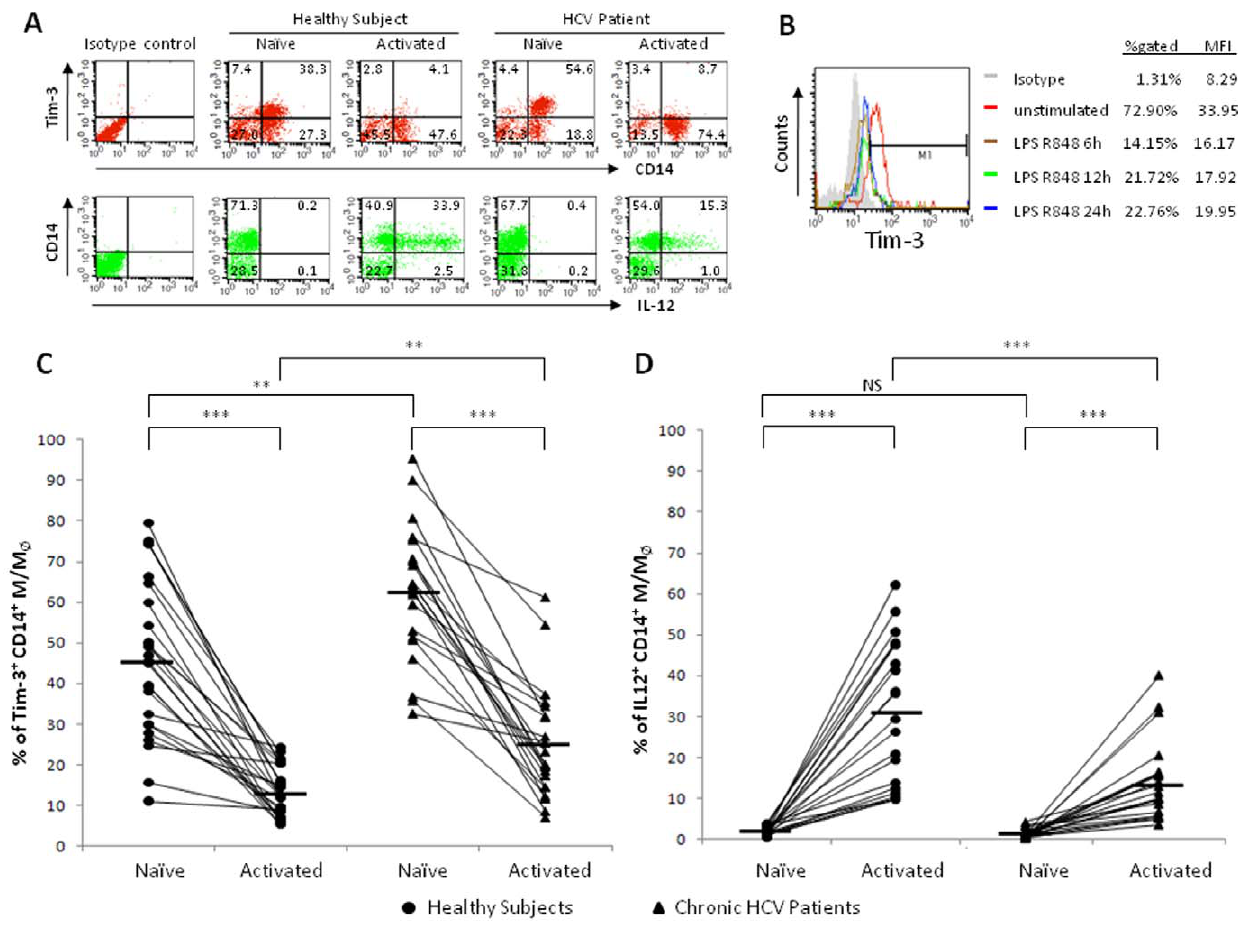
Figure 1. Tim-3 is over-expressed and IL-12 expression suppressed on CD14 + M/M Ø in chronically HCV-infected individuals. PBMC from chronically HCV-infected subjects (n=21) and healthy subjects (n=12) were stimulated with or without TLR ligands LPS and R848 for 18 h, followed by immunostaining with antibodies against Tim-3, IL-12 and CD14. Tim-3 and IL-12 expressions in un-stimulated and LPS/R848-stimulated CD14 + M/M Ø were examined by flow cytometry. A) Representative flow cytometric dot plots measuring Tim-3 expression and IL-12 production in CD14 + M/M Ø . B) Time-course of Tim-3 expression in primary healthy M/M Ø . PBMC stimulated with LPS and R848 for the indicated times. Tim-3 expression on CD14 + M/M Ø was assessed by flow cytometry; corresponding changes in % gated and MFI are shown with isotype control. C) Summary data of the percentage of Tim-3 + and D) IL-12 + cells in CD14 + M/M Ø of healthy subjects and chronically HCV-infected individuals, in naı¨ve and TLR- activated state, are shown. Each symbol represents an individual subject, and the horizontal bars represent median values. The p value (** , 0.01; *** , 0.001) is denoted above the group of study subjects.